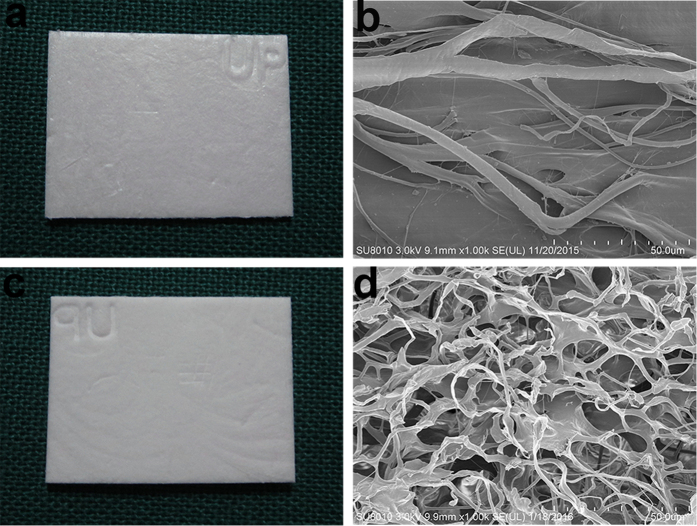
Structure of Heal-All Oral Cavity Repair Membrane.The basement membrane (a) and porous surface (c) were taken in kind. SEM images displayed the microstructure of the basement membrane surface (b) and porous surface (d).